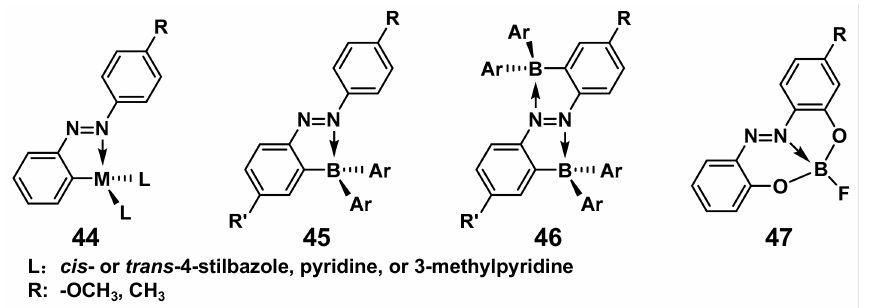
Figure 20. The molecular structure of a series heteroatomic coordination azobenzene complexs 44 – 47